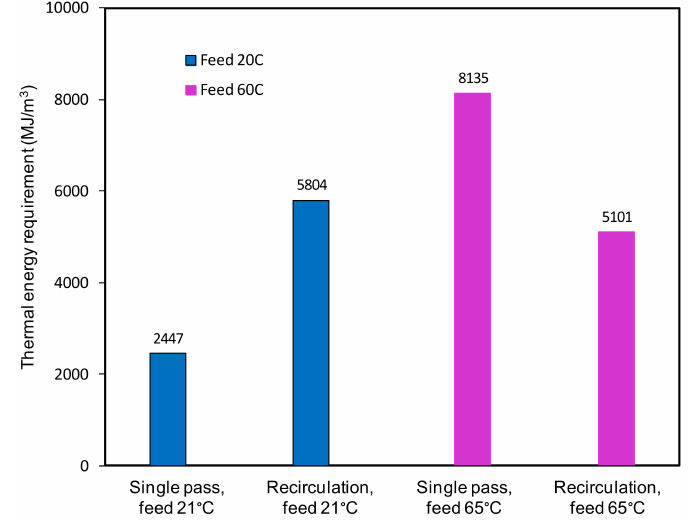
Figure 8. Thermal energy requirement per m 3 permeate for single pass and recirculation mode (feed velocity 0.05 m/s, vacuum 6